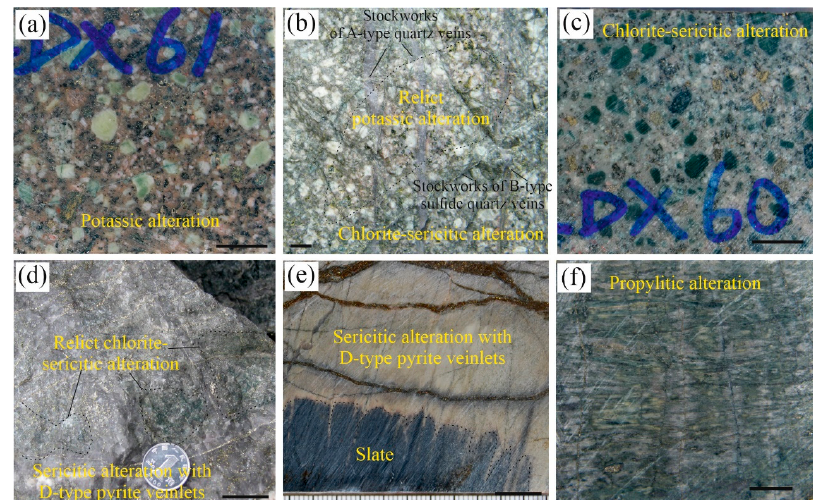
Figure 4. Major types of hydrothermal alteration at the Tongchang porphyry Cu deposit. ( a ) Potassic alteration in the granodiorite porphyry; ( b ) Chlorite-sericite overprinting on potassic alteration in the granodiorite porphyry; ( c ) Chlorite-sericitic alteration in the granodiorite porphyry; ( d ) Sericitic overprinting on chlorite-sericitic alteration in the granodiorite porphyry; ( e ) Sericitic alteration with pyrite-dominated veins in the slate; ( f ) Propylitic alteration in the phyllite. Scale bars are 1 cm. The scale in (d) is a Chinese one-dime coin.